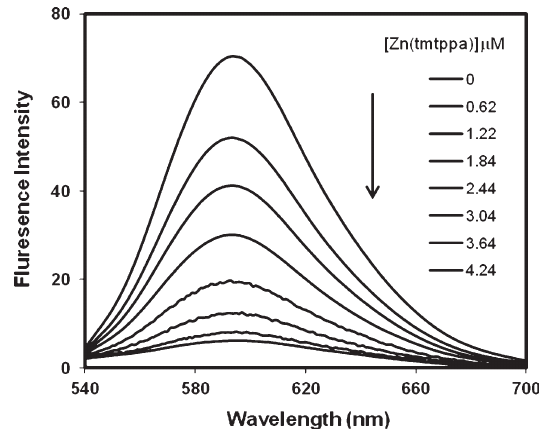
Fig. 7. The Stern-Volmer plot for quenching process of EB by